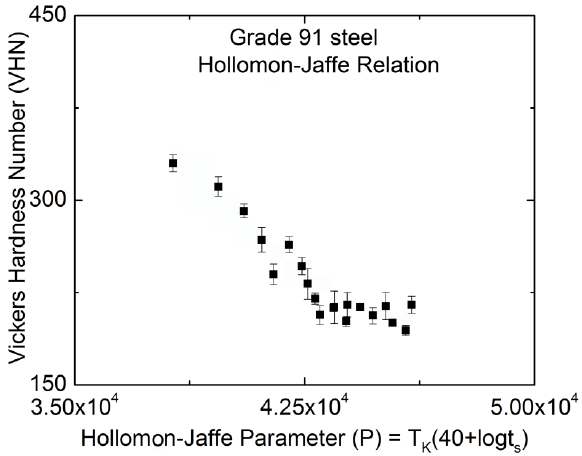
Figure 9. Hollomon-Jaffe relation of Grade 91 steel normalized at 1040 °C for 2 h and tempered at various temperatures and